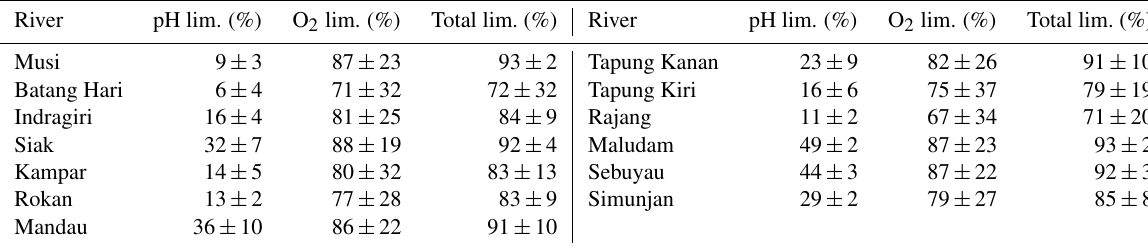
Table A3. pH and O 2 limitations in the individual rivers based on linear pH approach. River